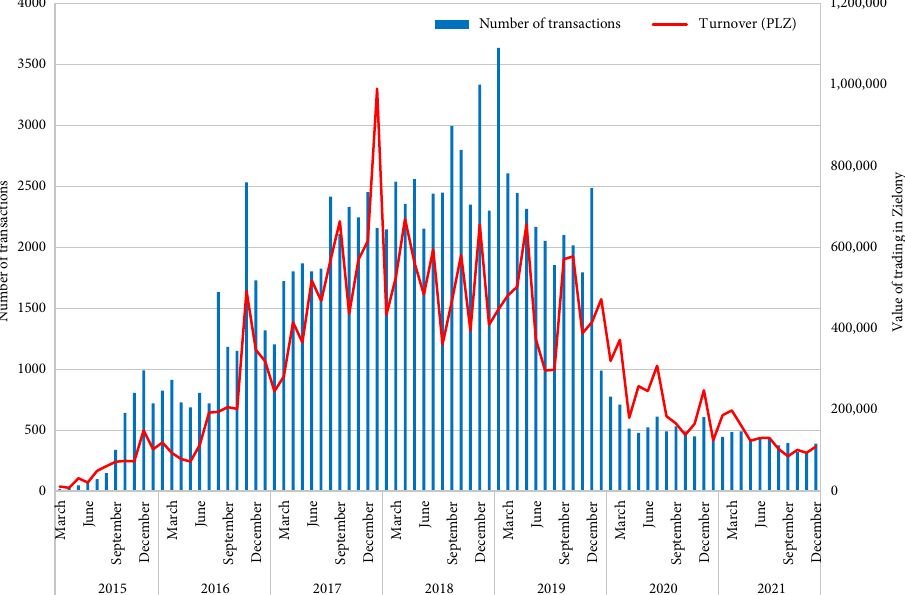
Figure 7. Number of transactions and value of trading in Zielony in Poland in the period 2015–2021 (source: own elaboration based on: Stępnicka et al., 2021; data obtained from the administrator of the Zielony complementary currency system in